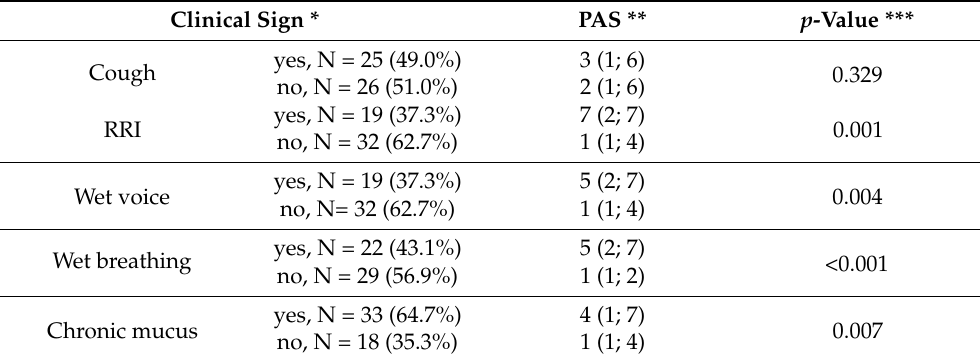
Table 5. Relationship between clinical signs and Penetration–Aspiration Scale (PAS) on VFSS.